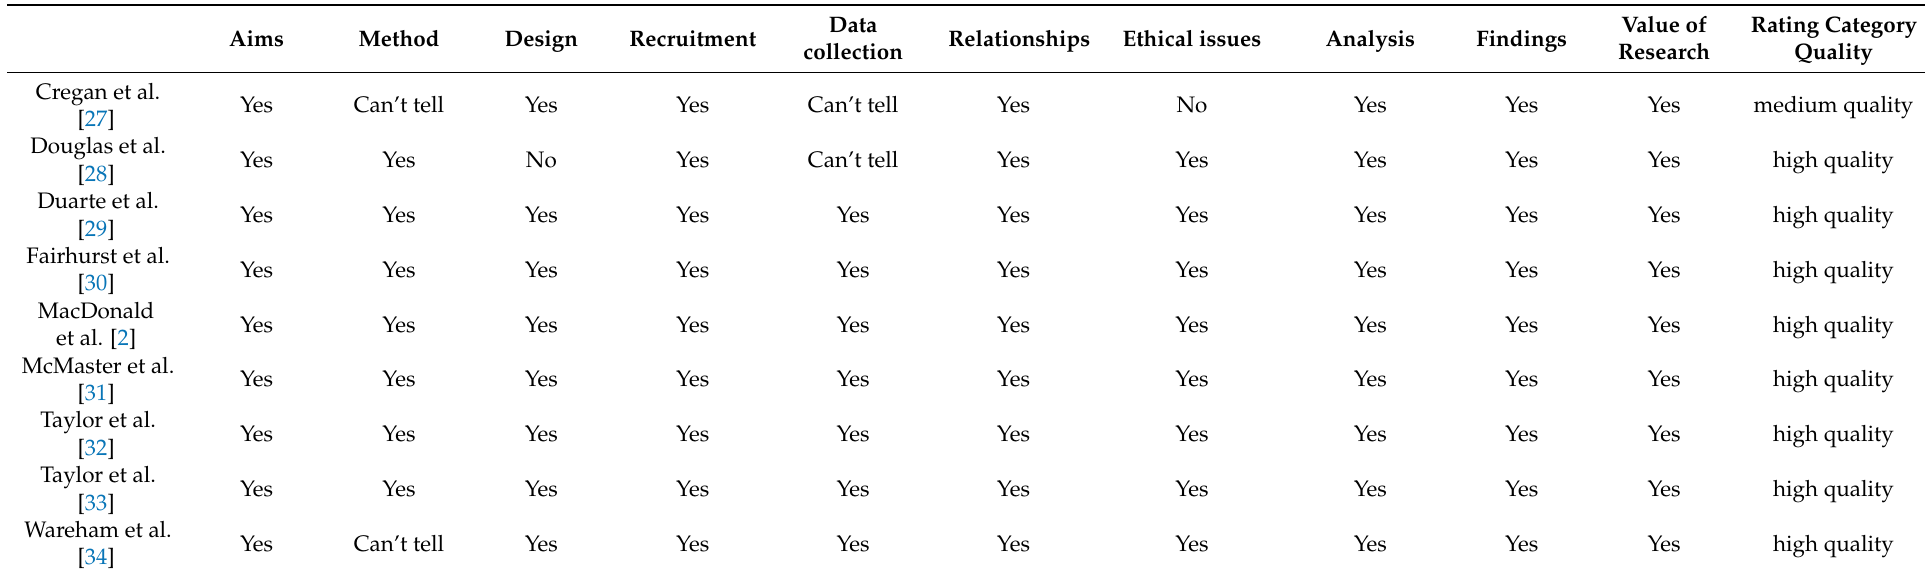
Table 3. Quality Appraisal of the Included